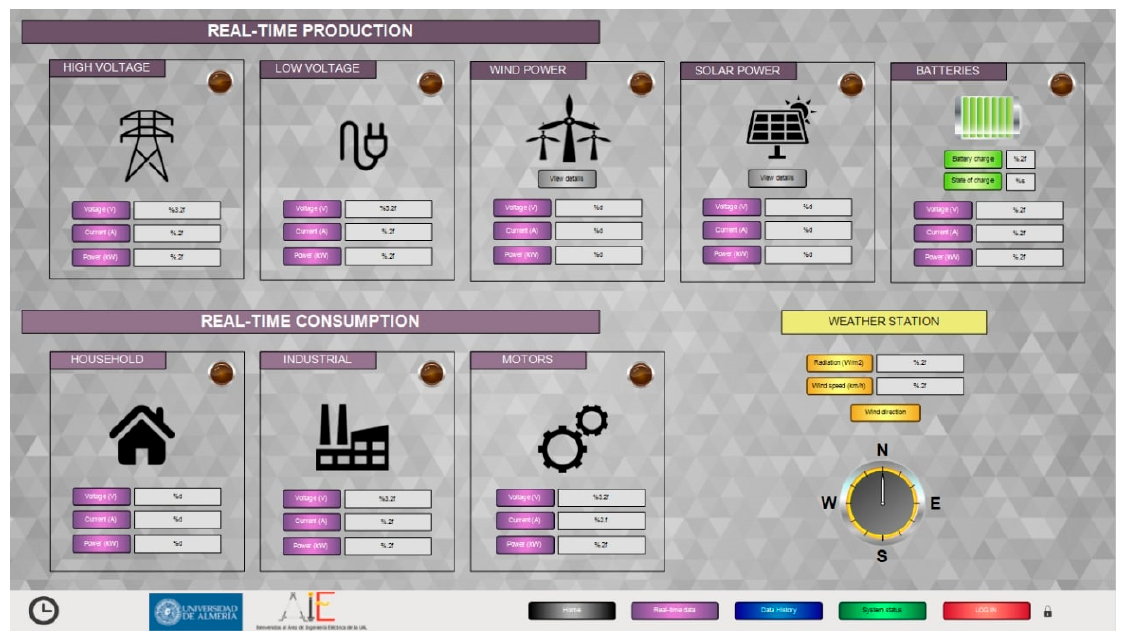
Figure 7. Real-time production and consumption view.